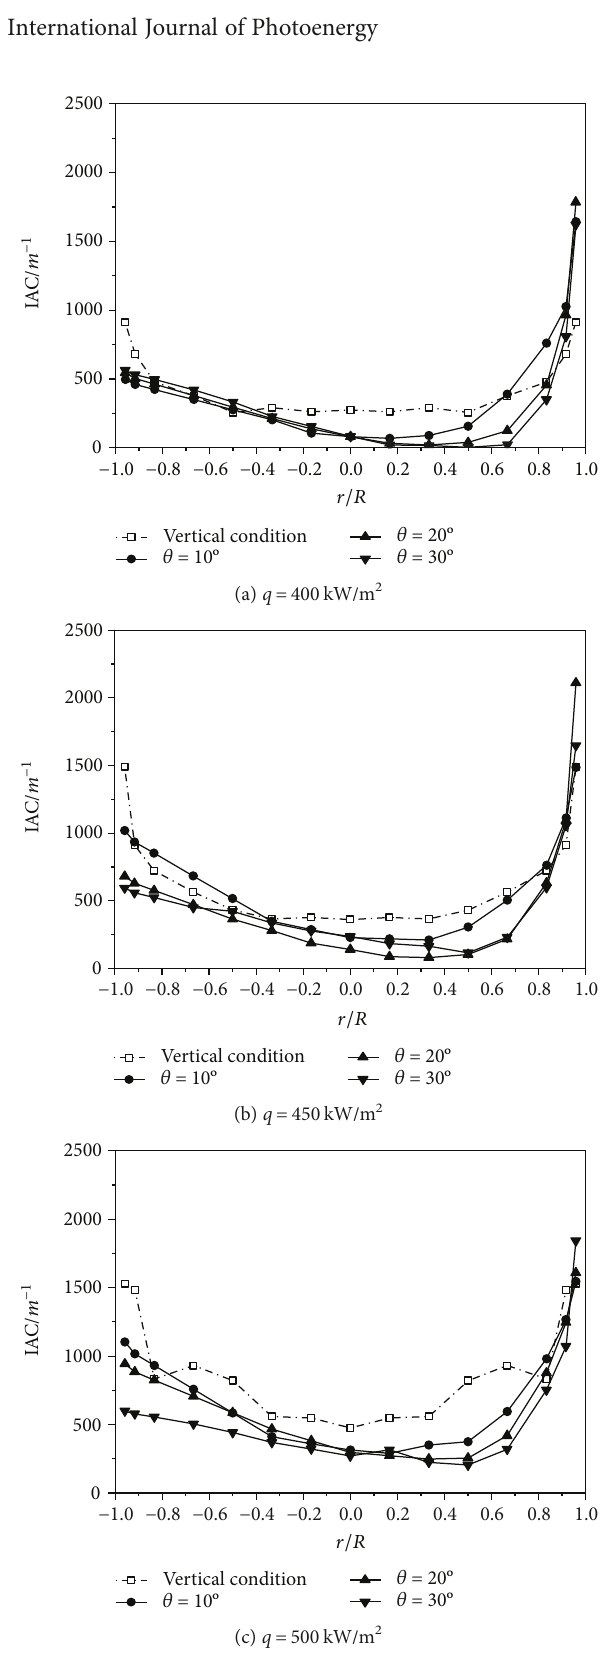
Figure 8: Inclination angle e ff ect on the interfacial area concentration on the direction of β = 90 ∘ in cross section ( P = 0 5 MPa, G = 500 kg/m 2